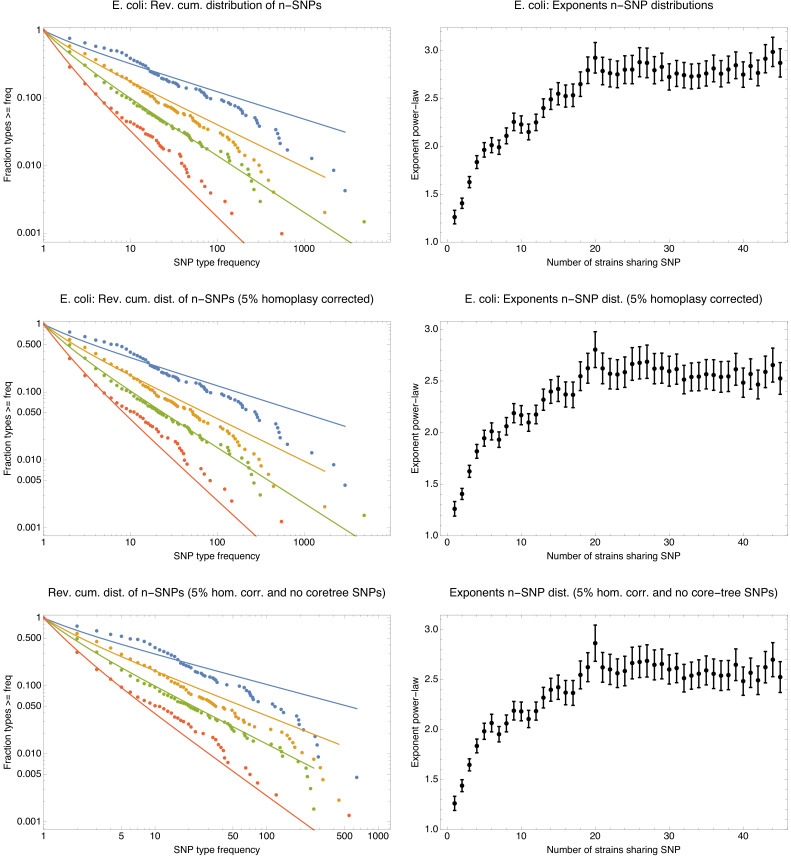
The n-SNP distributions are insensitive to removal of potential homoplasies and removal of n-SNPs corresponding to branches of the core tree.Distributions of n-SNP frequencies (left panels) and exponents of the power-law fits (right panels) for original E. coli core genome alignment (top row), the 5% homoplasy-corrected core genome alignment (middle row), and the 5% homoplasy-corrected alignment from which all n-SNPs that correspond to branches of the core tree have been removed (bottom row). The observed n-SNP distributions and exponents are very similar for all three datasets, showing that the n-SNP distributions are not affected by homoplasies, and that clonal SNPs make only a minor contribution to these distributions.